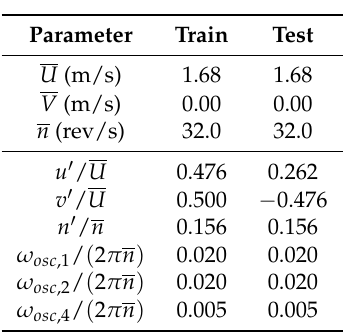
Table 1. Open water parameters for unsteady